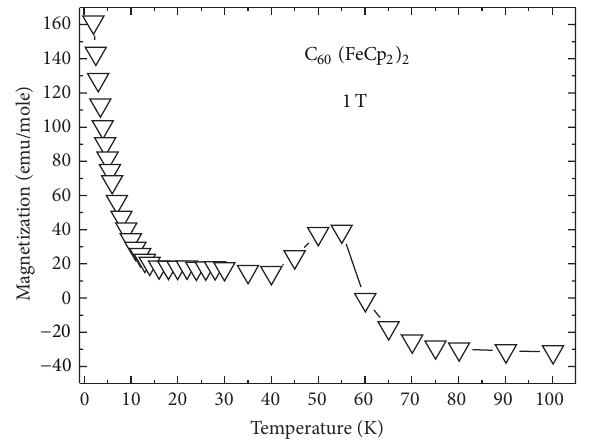
Figure 3: Temperature dependence of the C 60 (FeCp 2 ) 2 magnetiza-